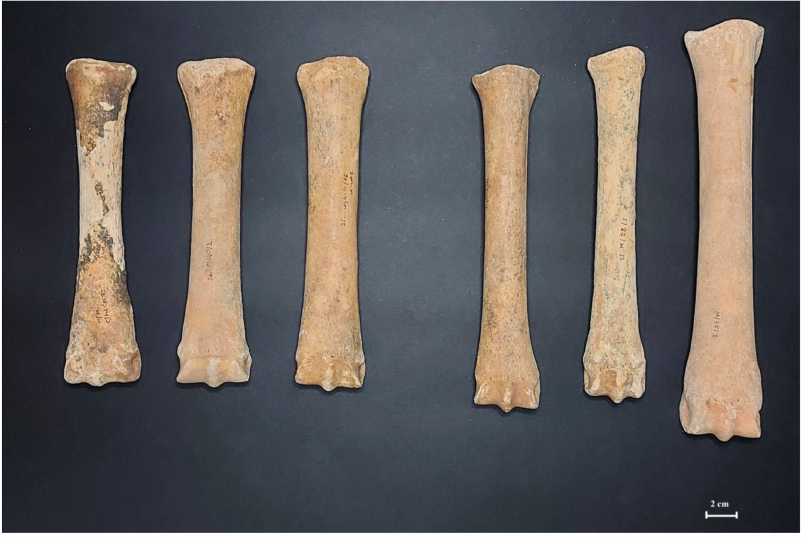
Figure 5. Horse metapodial discovered at Złotoryja